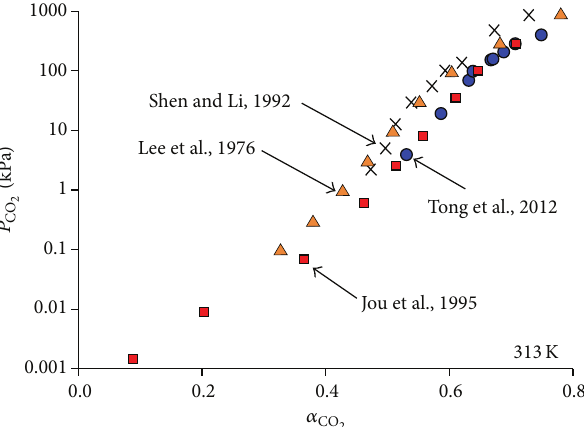
Figure 1: Solubility of CO 2 in 30% (w/w) aqueous MEA solutions at 313 K as a function of loading (moles of CO 2 per mole of MEA, 𝛼 ), from Tong et al.